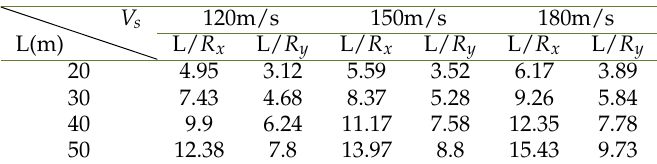
Table 3. Normalized length of barrettes